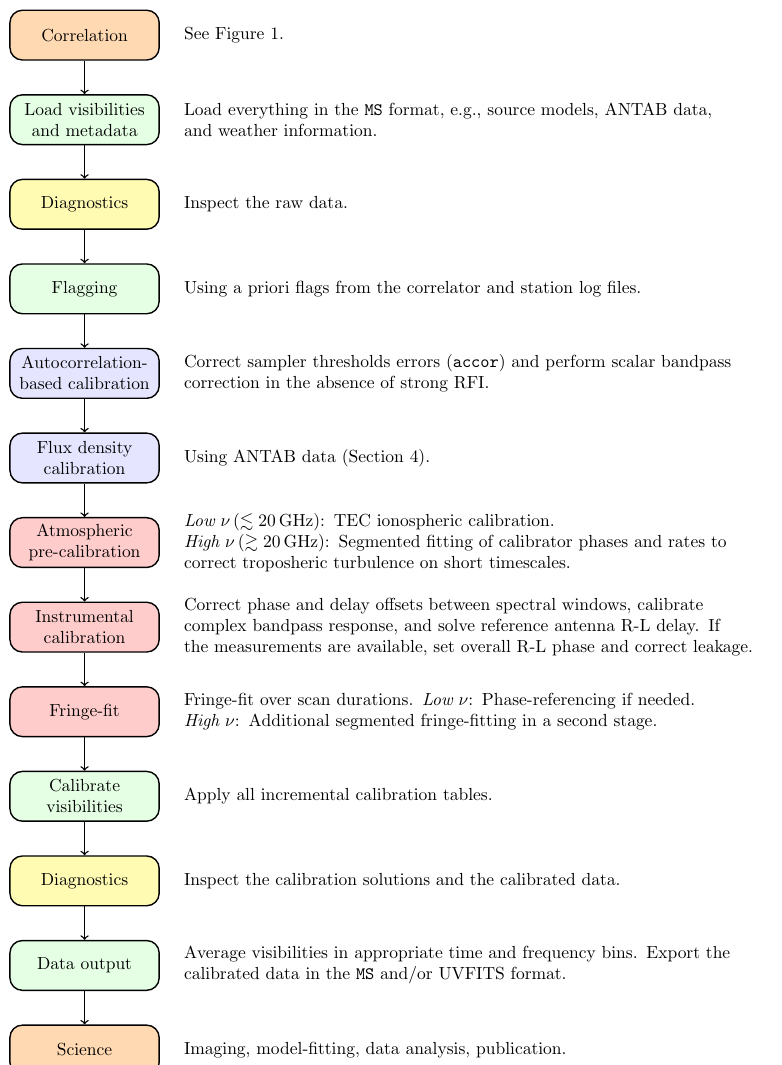
Figure 2. Flowchart of typical continuum VLBI data reduction steps shown in the order as implemented in the rPICARD pipeline (Section 3.2.1). Feed rotation angle effects are calibrated on-the-fly